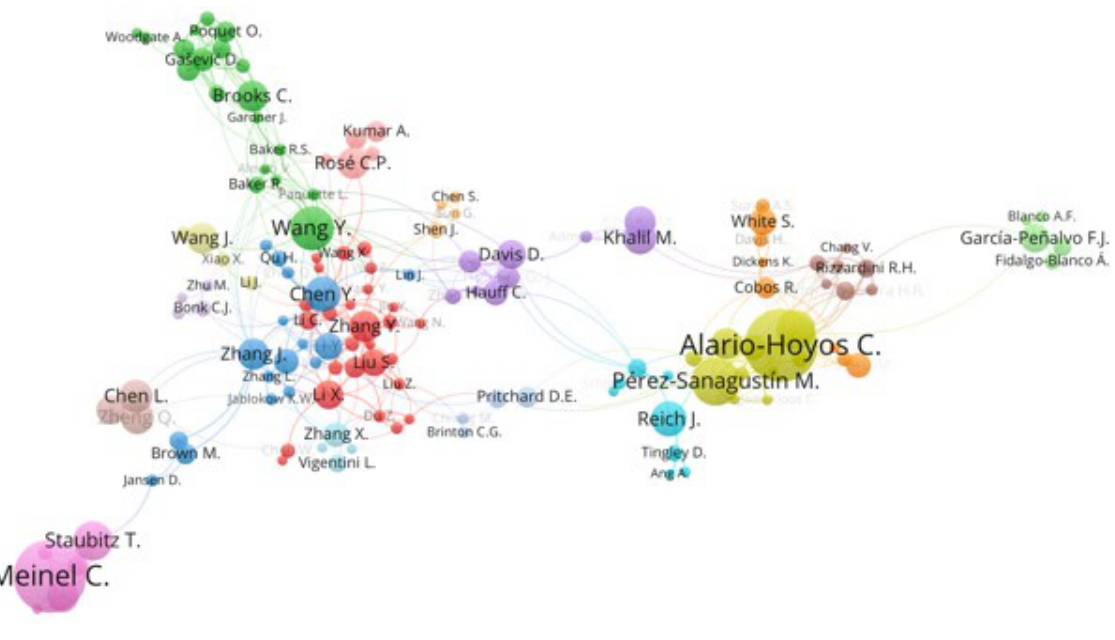
Figure 3. Network visualization map of MOOCs research